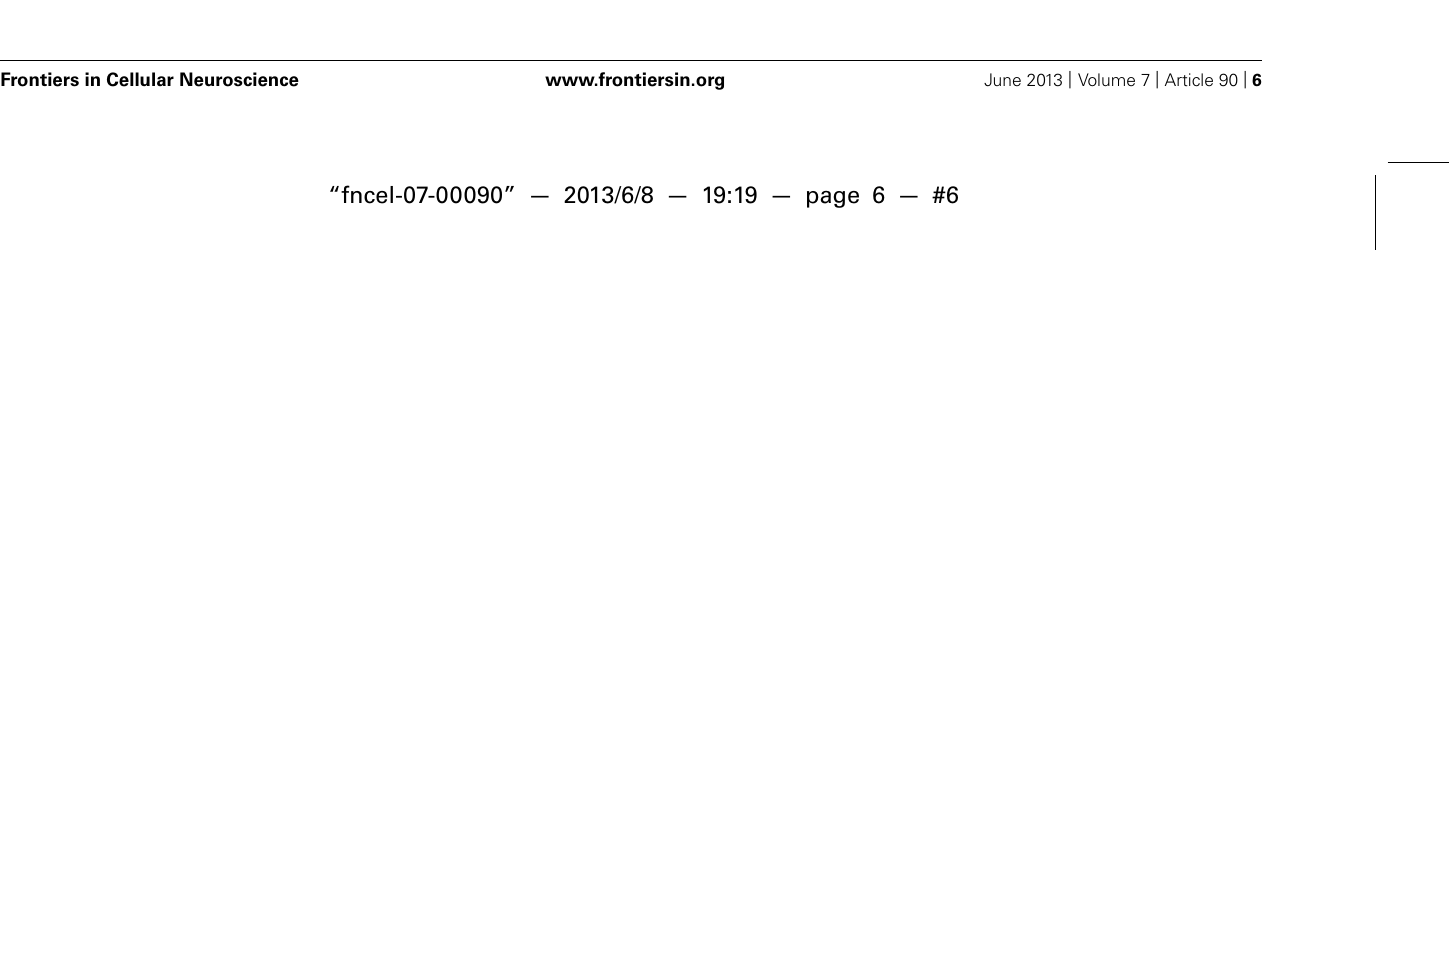
Data were obtained fromYao etal. (2010a,b). Significance with p < 0.000197 after the Bonferroni correction. HC, healthy control subjects; FENNS, first-episode neuroleptic-naïve patients with schizophrenia; BL, baseline; 4w, 4-week after antipsychotic treatment; UA, uric acid; G, guanine; Gr, guanosine; Xan, xanthine;TRP, tryptophan; MEL, melatonin; KYN, kynurenine;TYR, tyrosine; 5-HIAA, 5-hydroxyindoleacetic acid;TRPA,